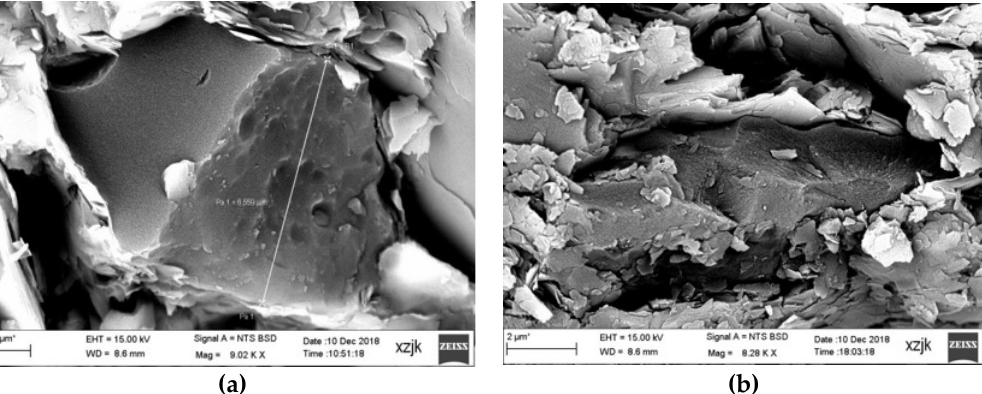
Figure 5. Microscopic characteristics of the carbonized organic matter in shale. ( a ) Tianye 1 Well, 1148.70 m, organic matter. ( b ) Section 1, Organic matter.